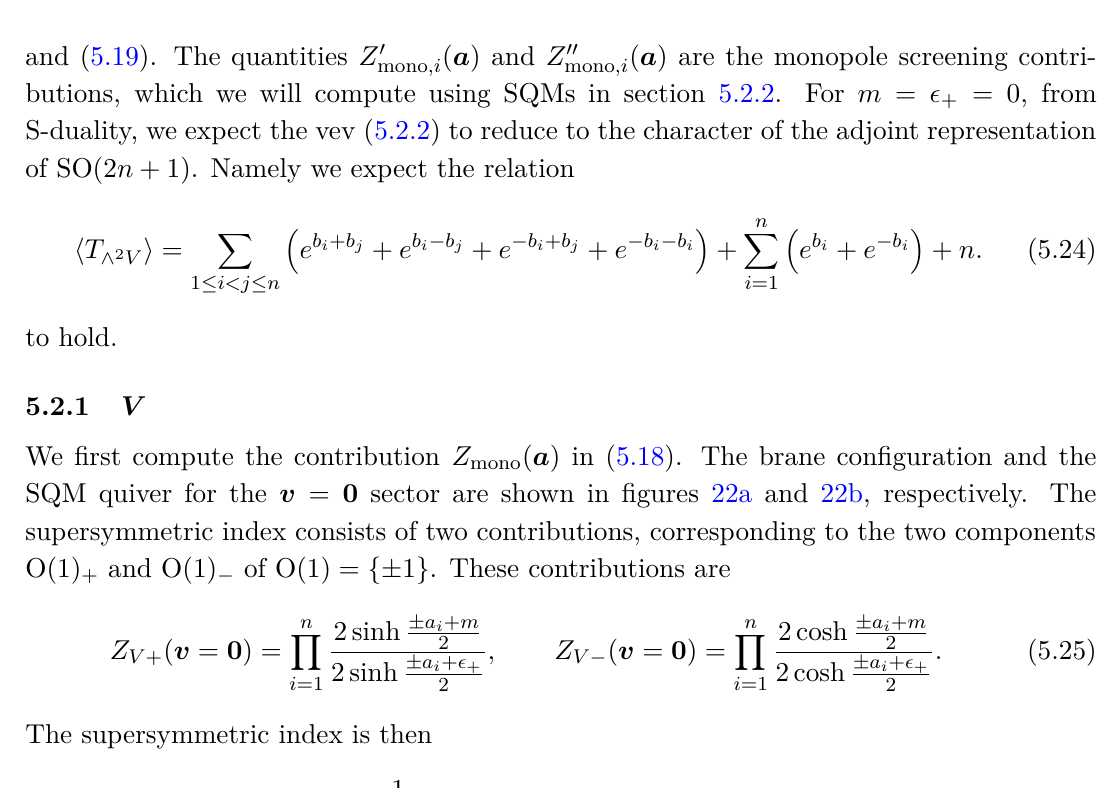
Figure 22. (a): the brane configuration for the monopole screening sector v = 0 of T V in the N = 2 ∗ USp(2 n ) gauge theory. (b): the corresponding quiver